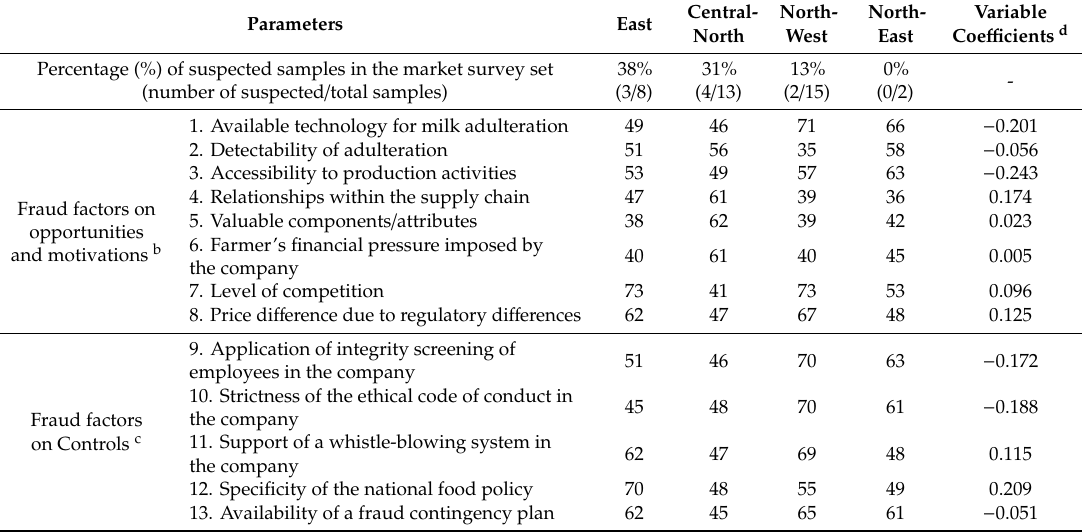
Table 4. The geographical prevalence of the suspected samples (flagged by the three criteria in Table 3), the mean ranks of scores of the fraud factors showing significant di ff erences between the four geographical areas a and the principal component regression (PCR) results.